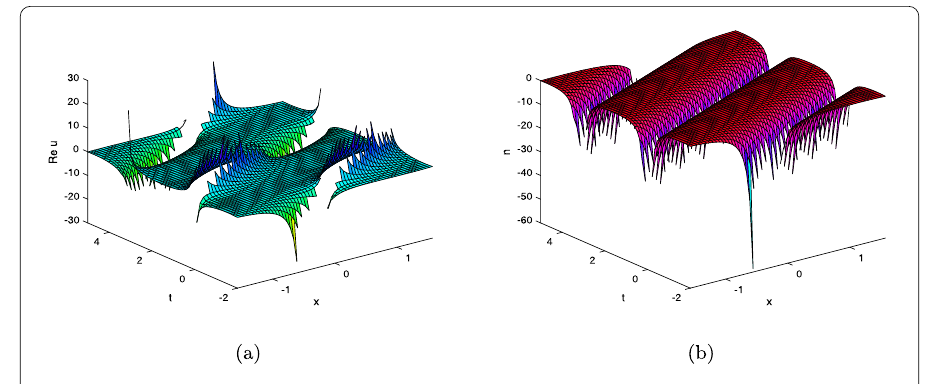
Figure 4 Tangent type wave with M = K = 1: ( a ) the real part of u ; ( b ) the periodical singularity of